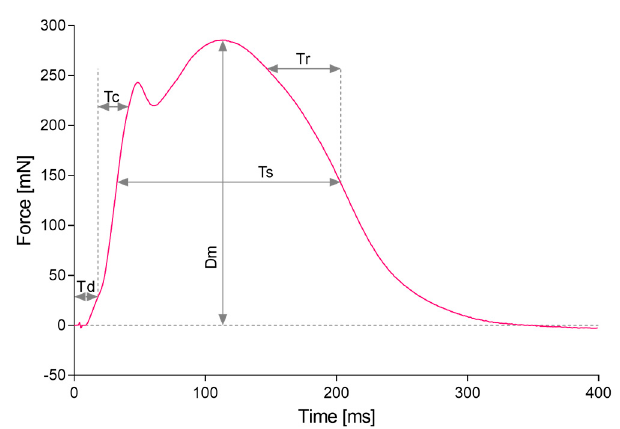
Figure 2. Typical MC sensor recording. Parameters extracted from measured response: Td—delay